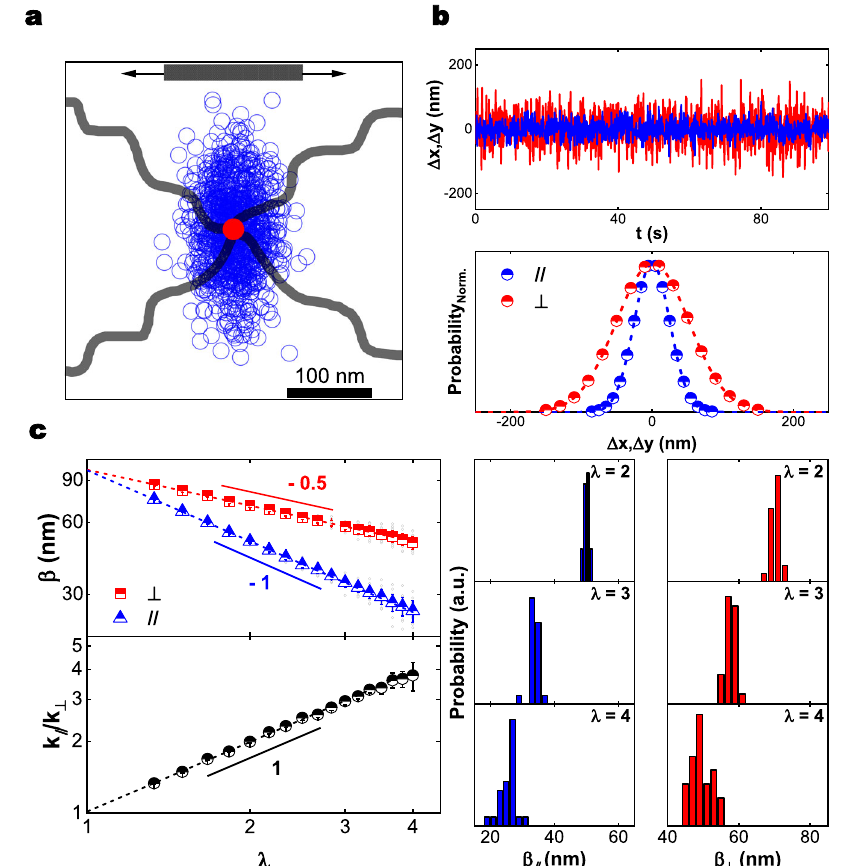
Fig. 4 | Fluctuationamplitudes of individualcrosslinksin elongatednetworks. Thedatasetis26phosphorescentcrosslinksselectedfromthosethatarebrightest. a Map of anisotropic crosslink fl uctuations during 100 s at λ =4 show less fl uctua- tion in the stretch direction. A superposed schematic representation of the tetra- functionalcrosslinkisincluded.Blackarrowsshowtheelongationdirection. b Top: representative time trace of position fl uctuations in the length ( ∥ ) and width ( ⊥ ) directions at extension ratio λ =4. Bottom: the respective probability distributions are consistent with being Gaussian. c Left top: On log-log scales, the fl uctuation